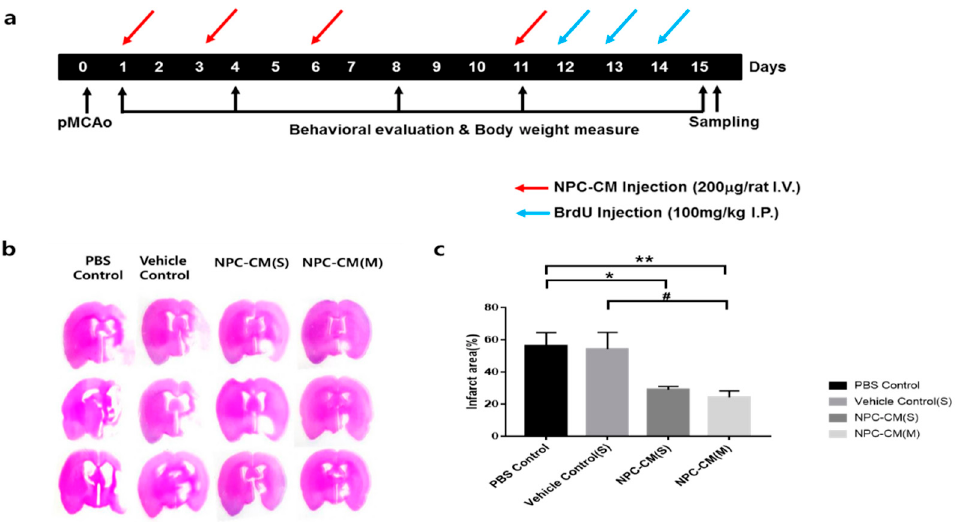
Figure 1. NPC-CM injection reduced the infarct size in a rat stroke model. ( a ) Timeline and experimental design of this study. NPC-CM administration, BrdU injection, and behavioral examination were conducted as indicated. The single injection of NPC-CM(S) was performed one day after pMCAO. Multiple injections of NPC-CM(M) were administered 4 times. Behavioral assessment was performed 5 times after pMCAO. ( b ) Representative 2,3,5-triphenyltetrazolium hydrochloride (TTC)-stained brain sections from rats treated with PBS control, vehicle control (basal medium with FGF-2), NPC-CM(S), and NPC-CM(M) on day 14 after NPC-CM treatment. ( c ) Bar graphs representing the infarct size in NPC-CM-treated stroke models. The infarct volume in the ipsilateral hemisphere is expressed as a percentage of the area of the contralateral hemisphere. Values ± SEM. * p = 0.044, ** p = 0.007 when compared with the controls. # p = 0.033. Control ( n = 5), vehicle control ( n = 6), NPC-CM(S) ( n = 8), NPC-CM(M) ( n = 8).